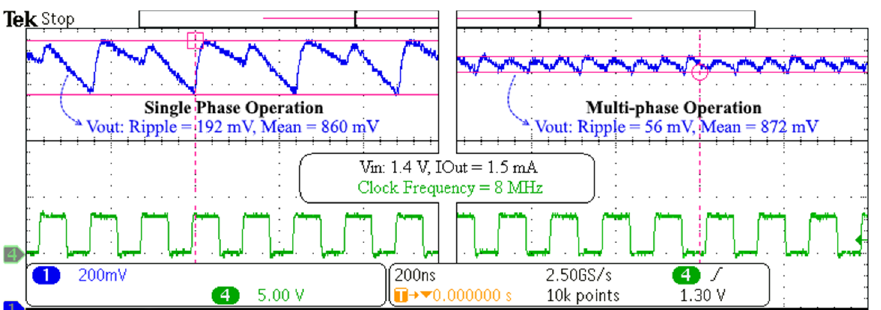
Figure 10. Single-phase vs. multi-phase operation of the implemented converter.